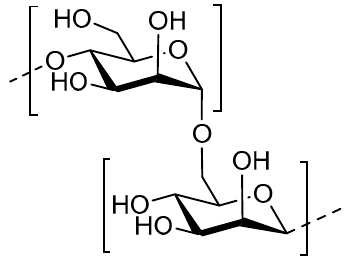
Figure 6. Structure of the main components of MOS; 1 → 4 linked D –mannose ( top ) and 1 → 6 linked D–mannose ( bottom ).